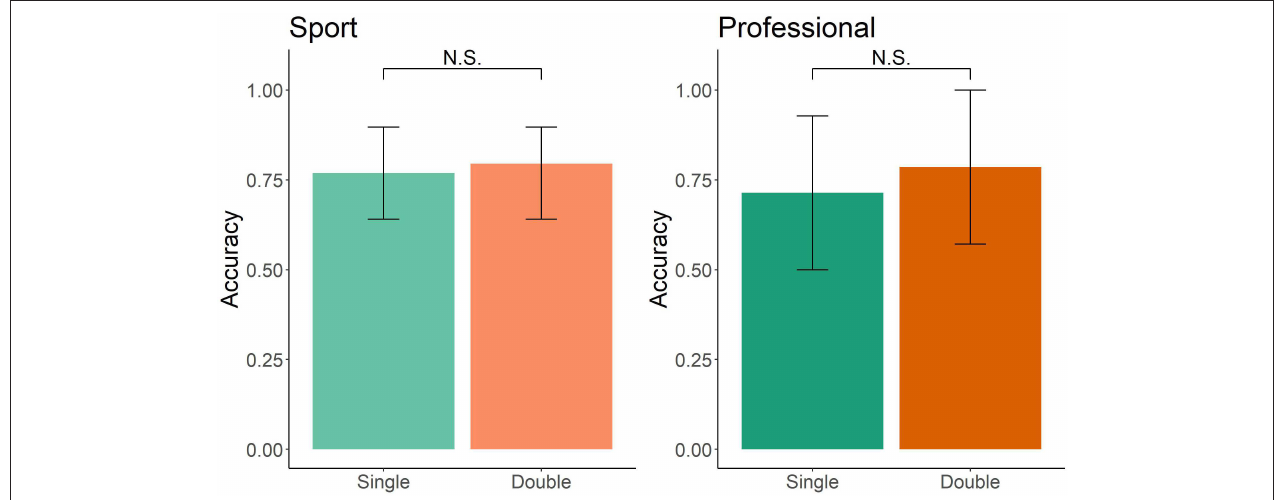
FIGURE 6 | Single-blind vs. double-blind search accuracy in sport and professional handler dog teams. Error bars represent 95% confidence